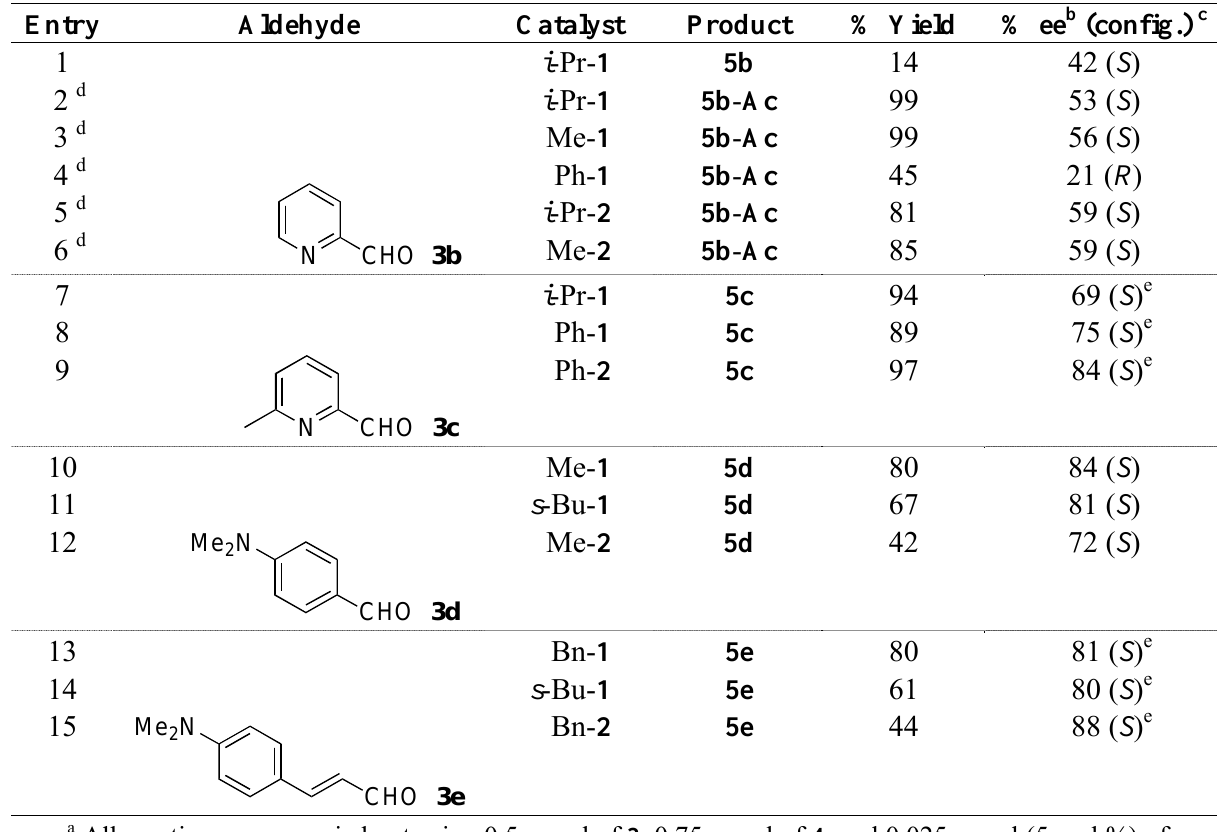
Table 3. Enantioselective addition of allyltributyltin 4a to amino aldehydes 3b – e .